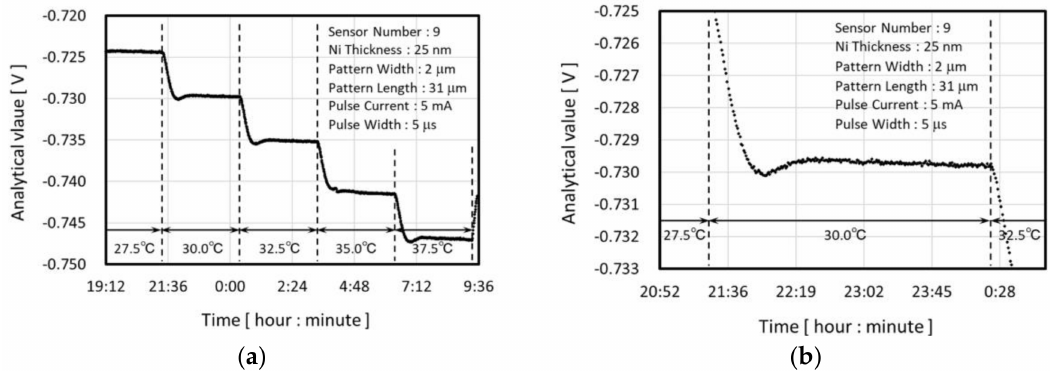
Figure 16. Example of the analytical value during the TCR evaluation ( a ) 1 cycle; ( b ) 30 ◦ C setting